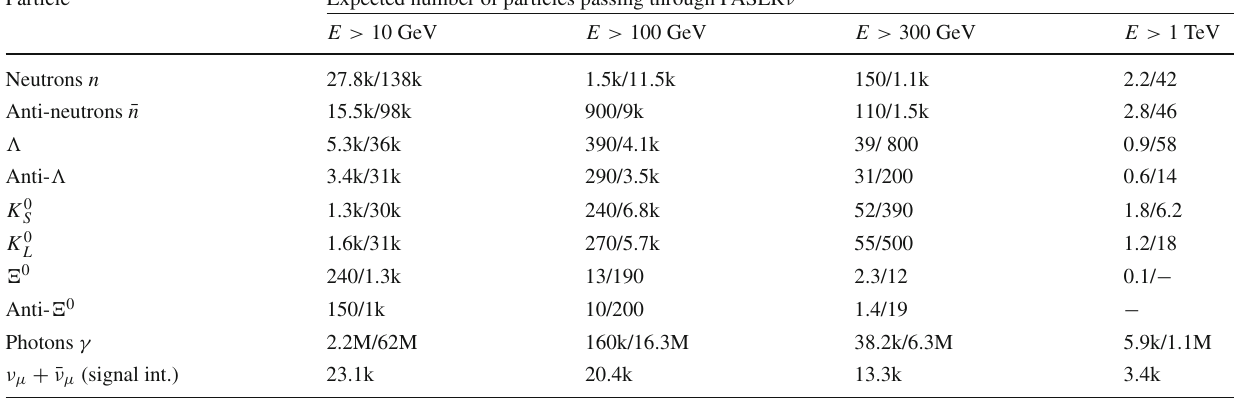
Table 4 The expected number of negative-muon-induced particles passing through FASER ν in LHC Run 3, as estimated by a dedicated FLUKA study. In each entry, the first number is the number of particles emerging from the rock in front of FASER ν , and the second is the num- ber of particles produced in muon interactions in the tungsten plates in